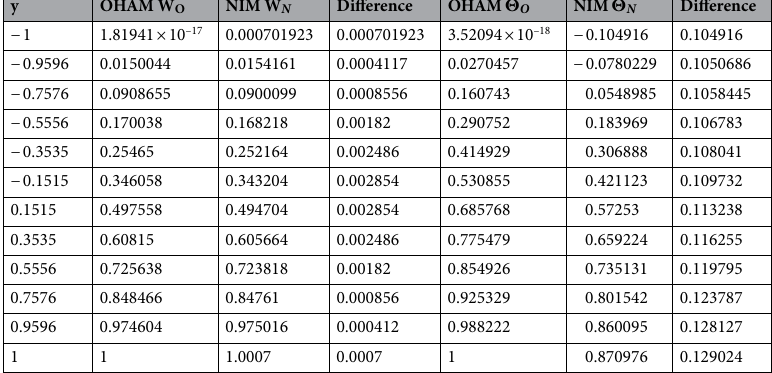
Table 3. For (cid:31) = 0.4, M = 0.0002, B = 0.3 and A = 0.4.